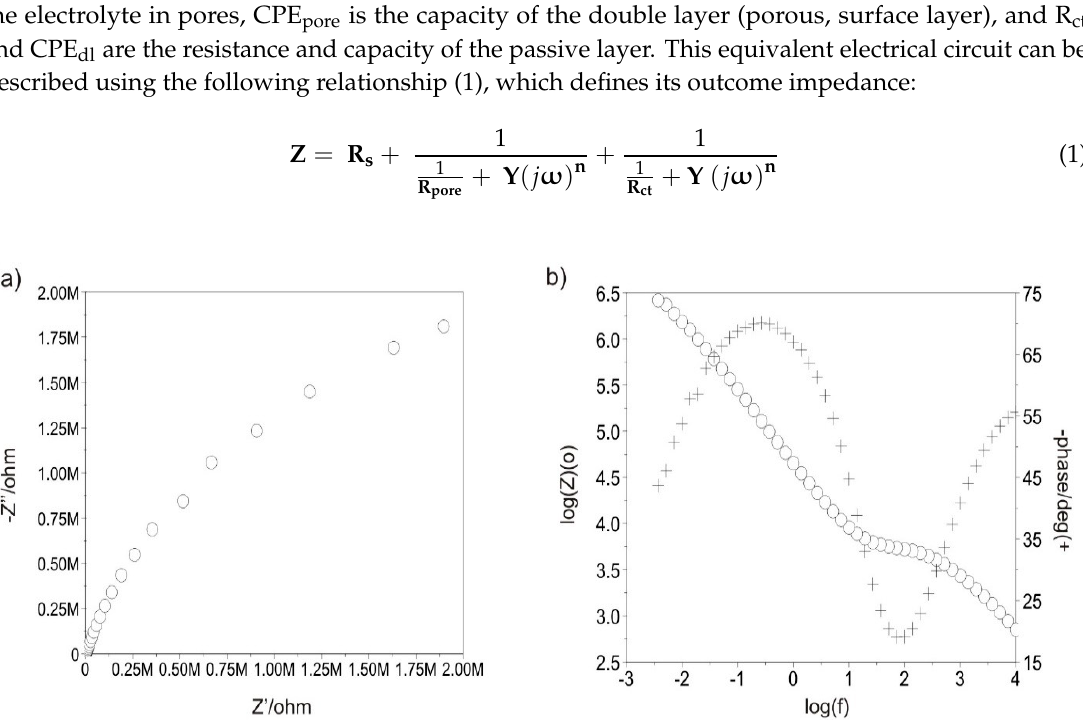
Figure 12. Sand-blasted sample with the DLC coating: ( a ) Nyquist diagram and ( b ) Bode diagram. ◦ : log(Z); +: -phase/deg. Figure 13. Equivalent electrical circuits of corrosion systems for: ( a ) sample in initial state, polished, ( b ) samples with the DLC coating and sample in initial state, sand-blasted. Table 5. EIS results. Sample